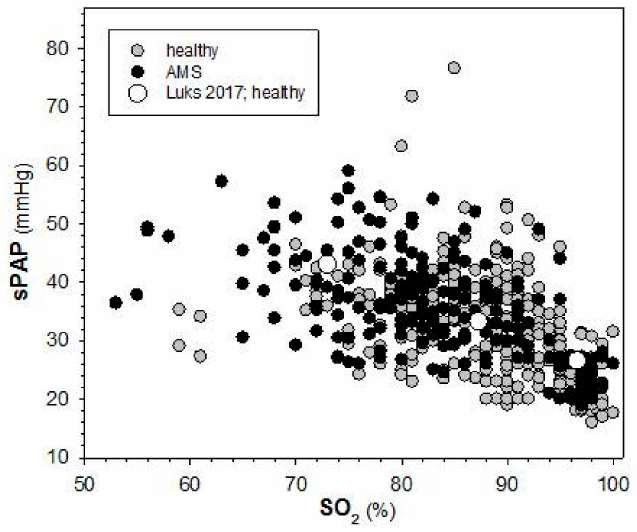
Figure 4. Relation between sPAP and SO 2 in acute mountain sickness (AMS) and in healthy controls. Individual values from the placebo-group of a study on e ff ects of ischemic preconditioning performed at 3450 m at the Jungfraujoch Research Station [58] and from the placebo group of a study on e ff ects of inhaled budesonide at the Capanna Margherita (4559 m) [41]. Data split by AMS have not been reported in these publications. Ascent to 3450 m was by train, to 4559 m by cable car and climbing (see legend to Figure 1). Open circles are the mean values reported in [39], for